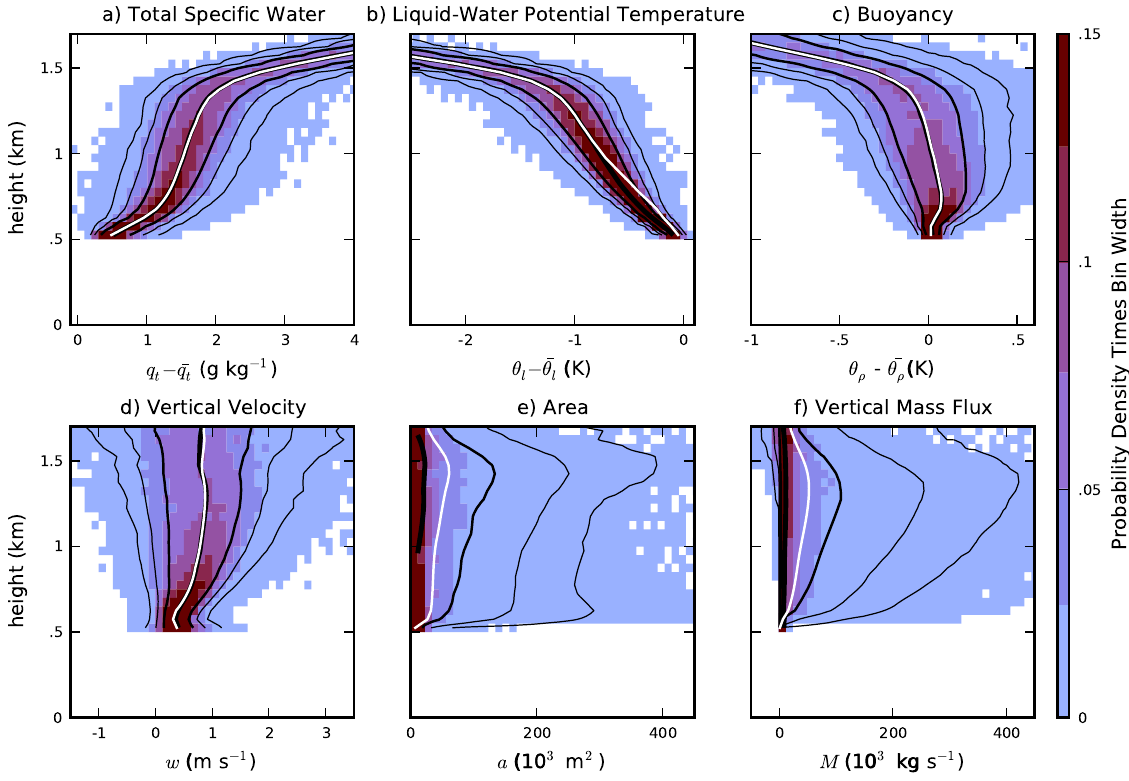
Fig. 9. Variation with height of the probabilities in range 1x ( P(x)1x ) of the condensed liquid-water regions of the tracked clouds having a certain (a) mean total specific water excess, (b) mean liquid-water potential temperature deficit, (c) mean buoyancy, (d) mean vertical velocity, (e) horizontal cross-sectional area, and (f) vertical mass flux. Black lines show contours of the cumulative distribution functions of each variable at the 0.01, 0.05, 0.16, 0.5, 0.84, 0.95, and 0.99 levels, from left to right. White line denotes the mean values for each